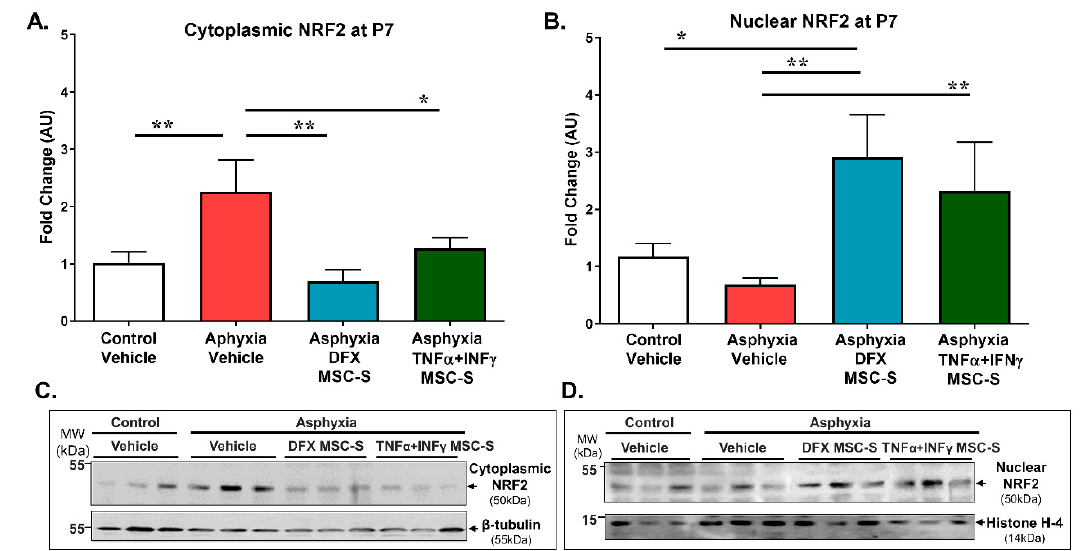
Figure 2. E ff ect of intranasal administration of DFX- or TNF- α + IFN- γ -MSC-S on nuclear and cytoplasmic NRF2 protein levels in hippocampus of PA-exposed and control rats at P7. ( A ) Cytoplasmic NRF2 protein levels; ( B ) Nuclear NRF2 protein levels. Hippocampal protein levels were evaluated by Western blots in control (white bar) and asphyxia-exposed rats (red bar), intranasally treated with vehicle- or DFX-MSC-S (cyan bar)- or TNF- α + IFN- γ -MSC-S (green bar)-MSC-S at P7. β -tubulin and histone H-4 were used as normalizers for cytoplasmic and nuclear extracts, respectively. Representative Western blot images are shown ( C ) and ( D ). Data are presented as ratio of protein / normalizer level, relative to vehicle controls. ( A ) PA-exposed rats treated with vehicle (AS) (red bar) showed an increased cytoplasmic NRF2 protein levels versus vehicle-treated (CS) controls (white bar). Administration of a single dose of DFX-MSC-S (cyan bar) or TNF- α + IFN- γ -MSC-S (green bar) reversed the e ff ect of PA on cytoplasmic NRF2 levels. Data represent means ± SEM. One-way ANOVA, F (3,23) = 3.973, ** p < 0.05. Benjamini, Hochberg, and Yekutieli post-hoc: * p < 0.05, CS v / s AS, ** p < 0.005; AS v / s Asphyxia DFX-MSC-S; * p < 0.05; AS v / s Asphyxia-TNF- α + IFN- γ -MSC-S, N = 6–7 samples per group. ( B ). A single intranasal administration of DFX-MSC-S (cyan bar) or TNF- α + IFN- γ -MSC-S (green bar) to PA-exposed rats increased nuclear NRF2 levels, compared to AS (red bar) and to CS (white